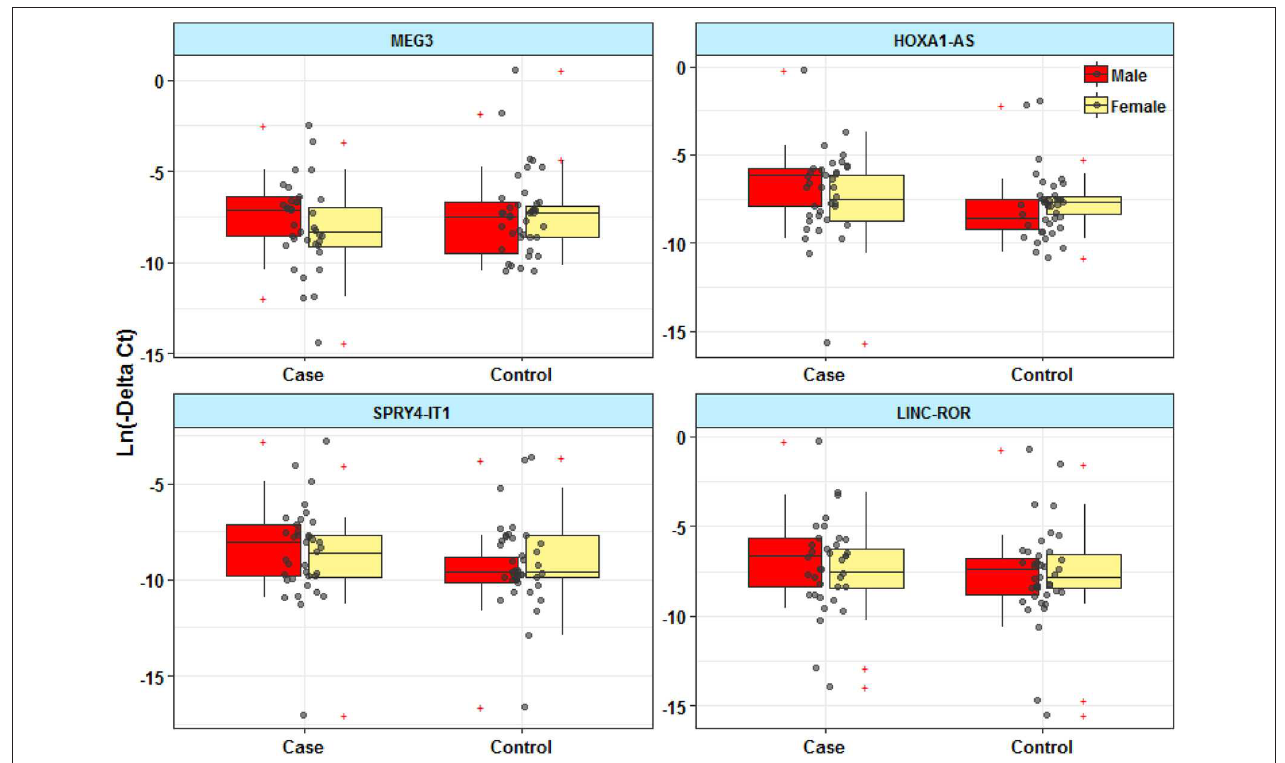
FIGURE 1 | Expression levels of lncRNAs in peripheral blood of epileptic patients and healthy